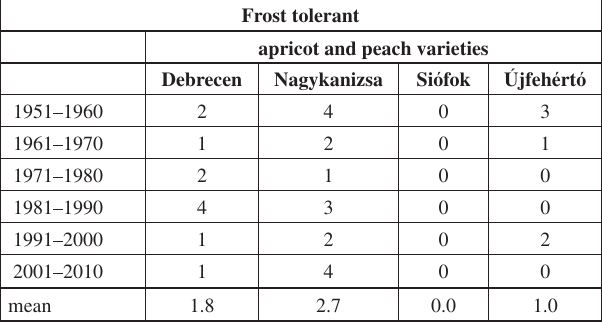
Table 7 – The frequency of years expecting frost damages on frost tolerant apricot and peach varieties during the 60 year long period examined and their distribution according to decennia